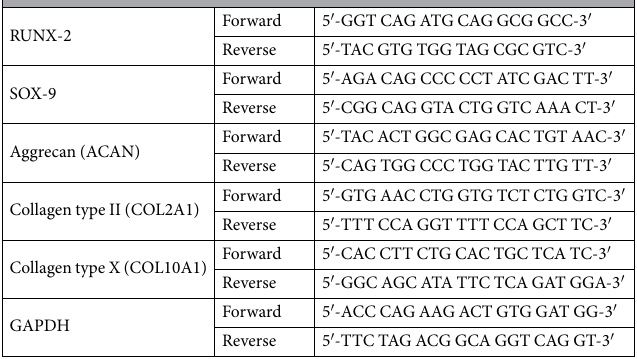
Table 1. Real time PCR primers used to quantify mRNA expression from human